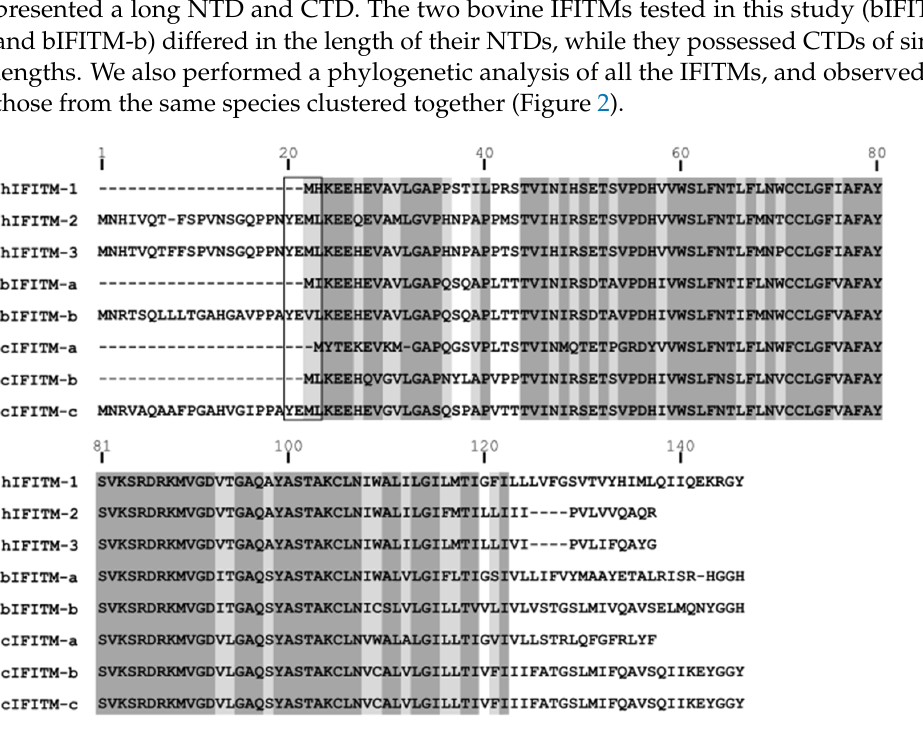
Figure 2. Phylogenetic tree of human, rabbit, bovine, wild boar, and camel IFITMs. The phylogenetic tree was built using the Maximum Likelihood method and Tamura-Nei model with MEGA X